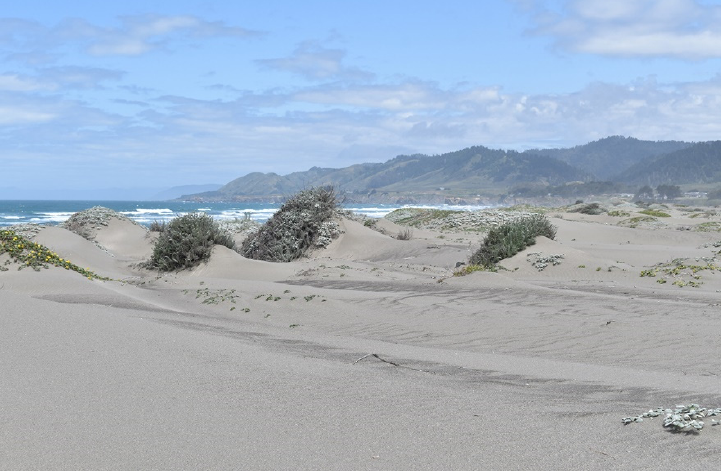
Figure 5. Foredune at MacKerricher dunes restored using herbicides/burning, showing nebkha.